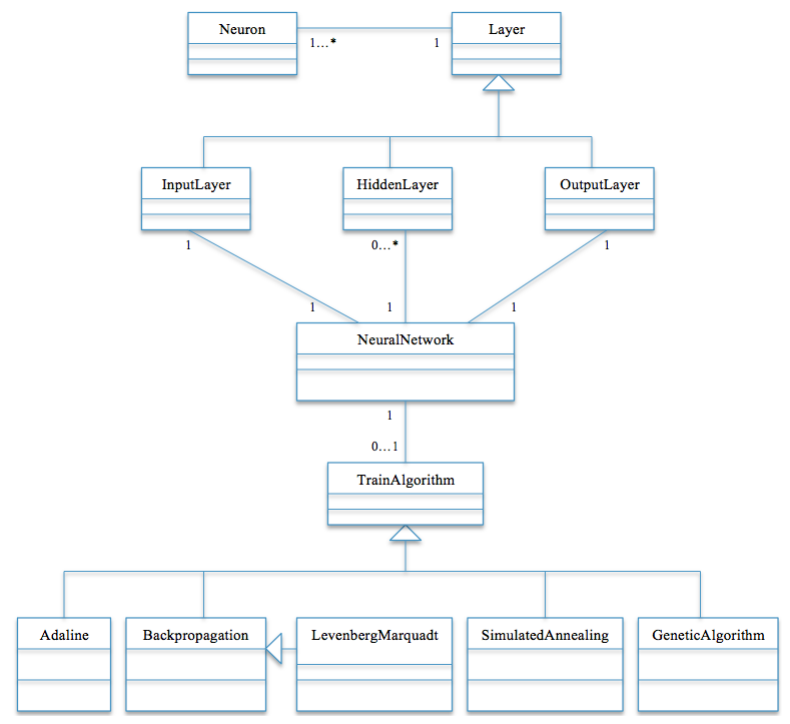
Figure 2. Class diagram of the